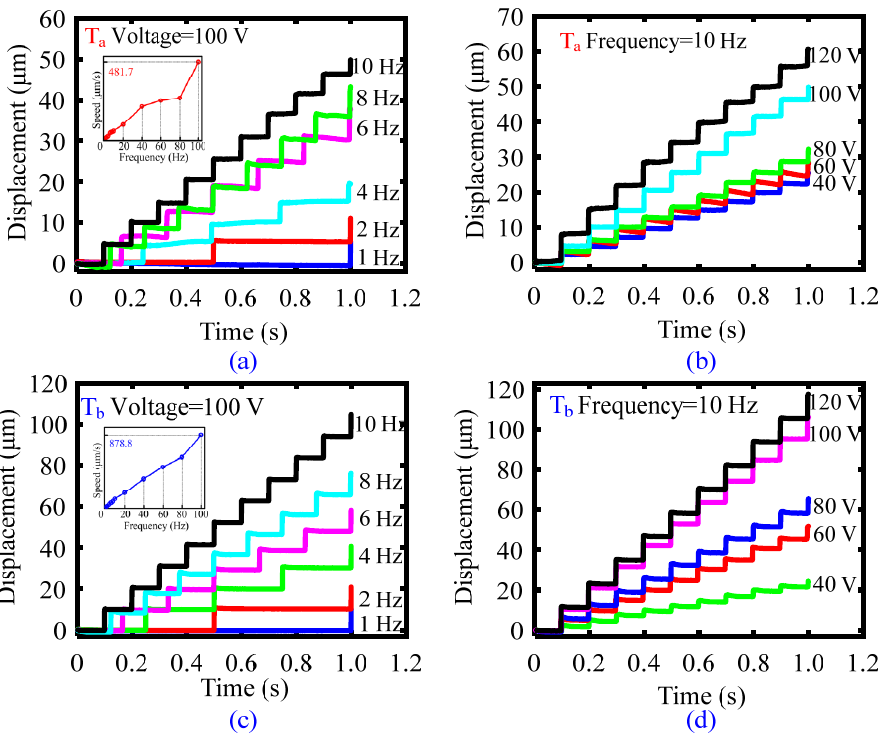
Figure 10. Output displacement change over time obtained under various driving voltages (40 to 120 V) and driving frequencies (1 to 10 Hz): ( a , b ) output characteristics of the actuator with the T a microstructure, ( c , d ) output characteristics of the actuator with the T b microstructure.